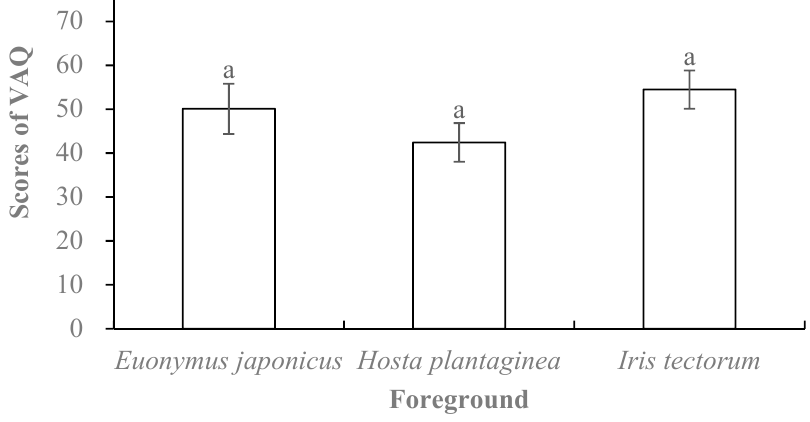
Figure 5. Visual aesthetic quality (VAQ) of three foreground plant species.